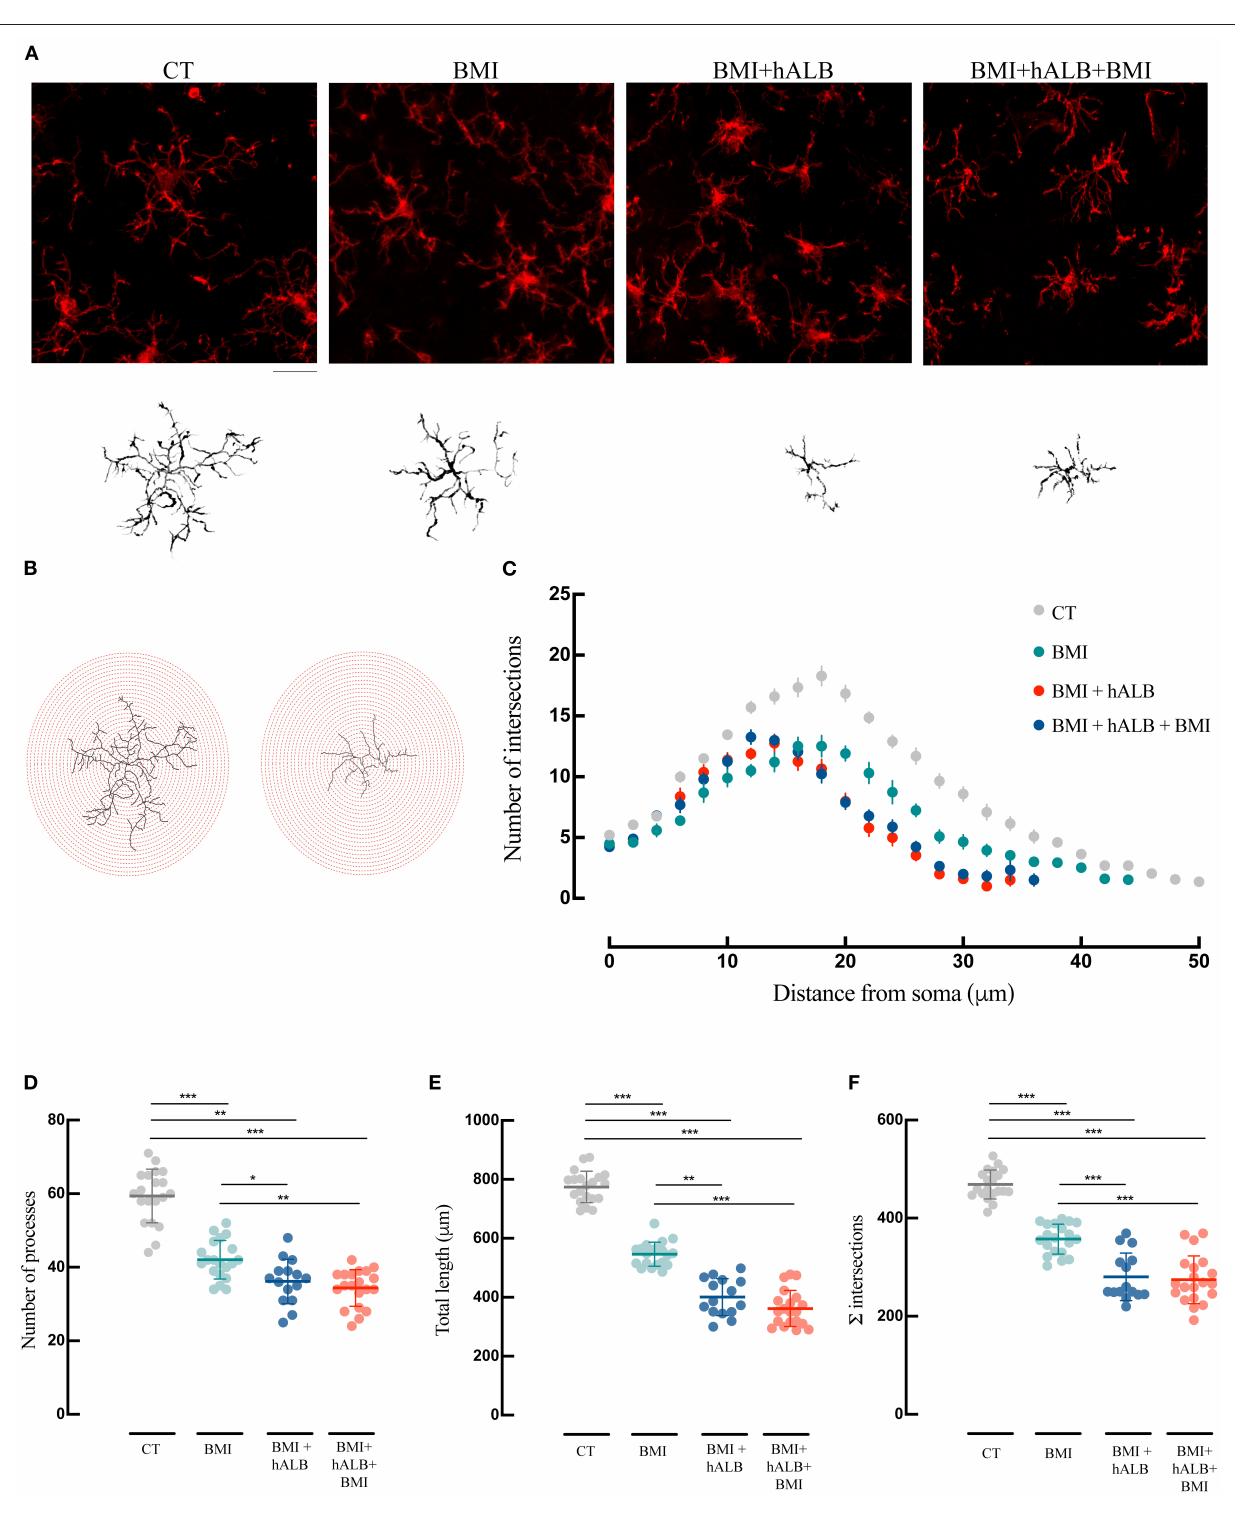
FIGURE 5 | Morphological analysis and reconstruction of microglia in ventral hippocampal CA1. (A) Representative morphologies of microglial cells in Iba-1 immunofluorescence coronal sections of the ventral CA1 hippocampal region are represented for CT, BMI, BMI + hALB, and BMI + hALB + BMI; the correspondent reconstruction of the microglial cell is illustrated in the bottom part of the panel. Calibration bar = 20 µ m. (B) Representative Sholl analysis setting of a manually reconstructed microglia cell from CT (left) and BMI + hALB + BMI (right). The circles centered around the soma are separated by radial intervals of 2 µ m. (C) Number